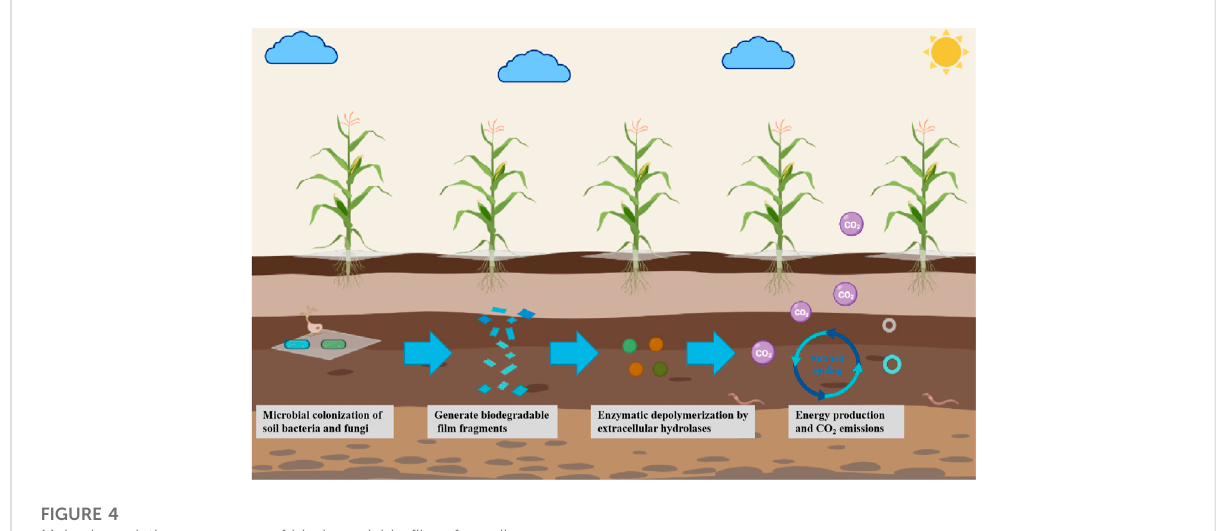
FIGURE 4 Main degradation processes of biodegradable fi lms for